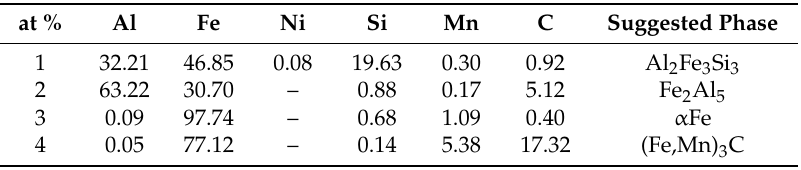
Figure 11. Diffraction patterns obtained from areas denoted by 1–4 in Figure 10. ( τ 1 : Al 2 Fe 3 Si 3 ; η : Fe 2 Al 5 ; α : Ferrite). Table 5. EDS results and suggested phases in the area denoted as 1–4 in Figure 10a.